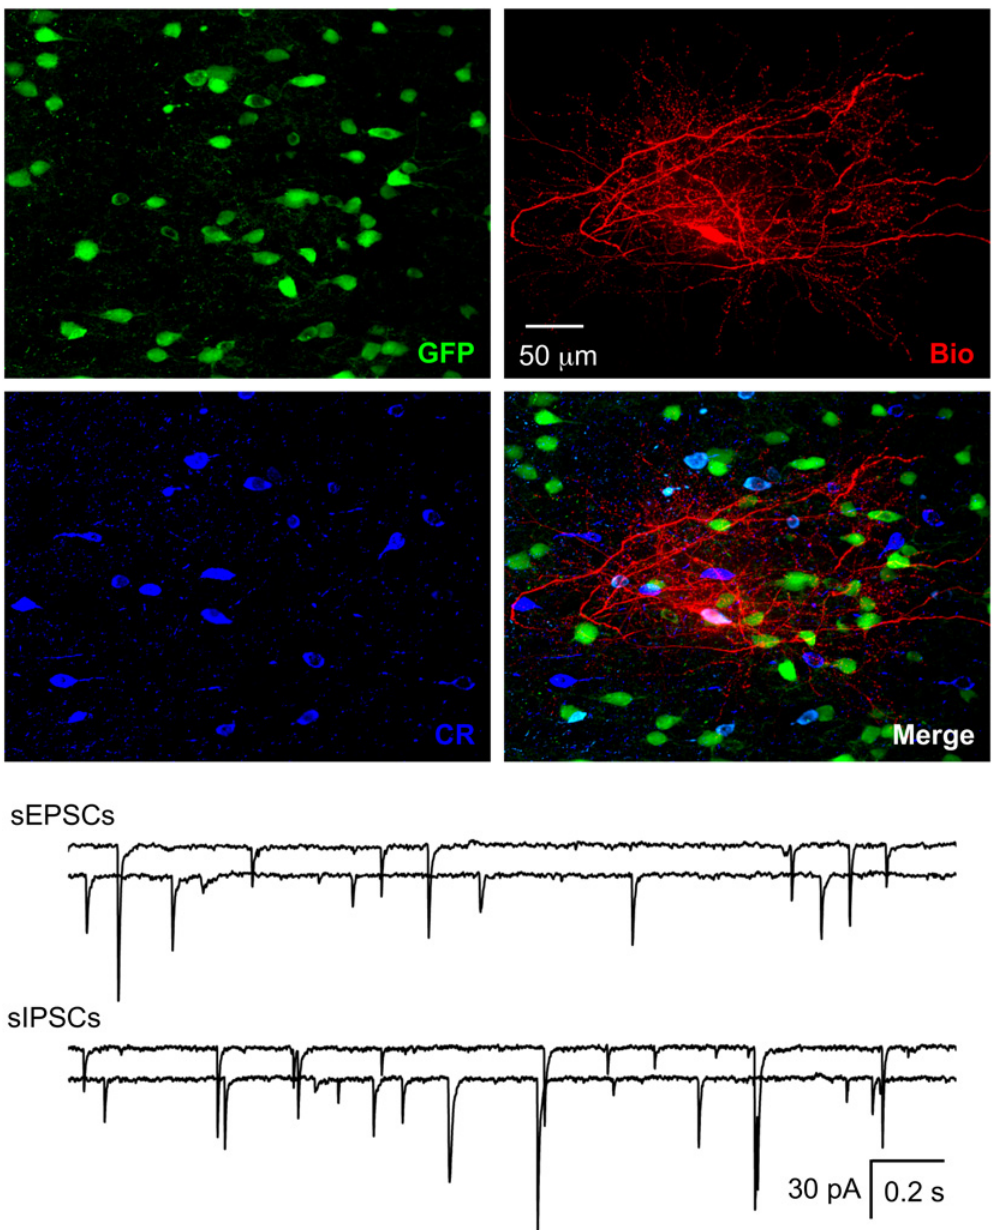
Fig 3. Functional integration of CR-ir hNPCs. The section with the recorded hNPC was further processed with anti-CR and the recorded hNPC was found to be a CR-ir interneuron. Spontaneous IPSCs and EPSCs were found in CR-ir hNPCs. Representative traces for sIPSCs and sEPSCs from two CR-ir interneurons are